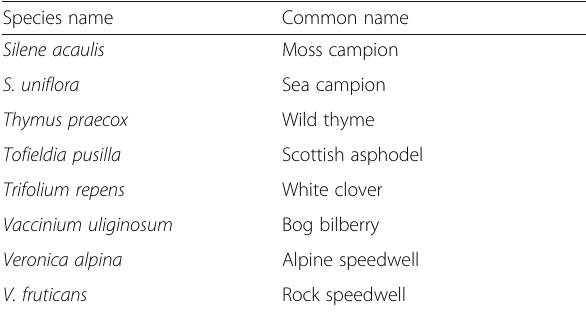
Table 1 List of species identified at Skaftafell in this study (Kristinsson 2013)